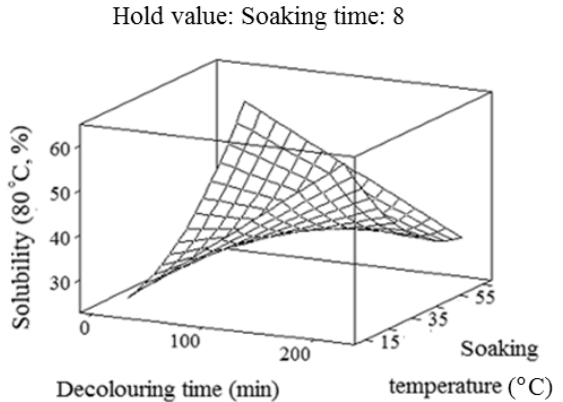
Figure 3. Response surface plot for explaining the variation of solubility (80 °C, 30 min) as a function of decolouring time and soaking